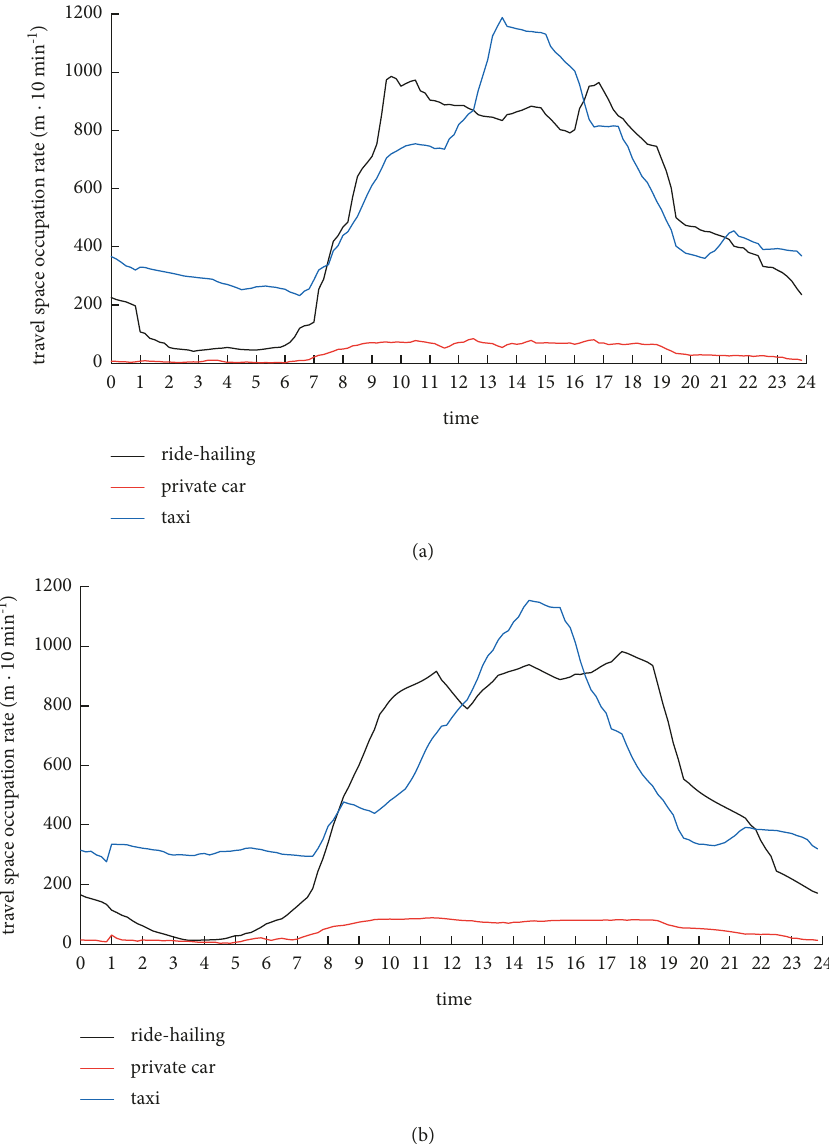
Figure 7: Average travel space occupation rate of ride-hailing vehicles, private cars, and taxis. (a) Working day. (b)